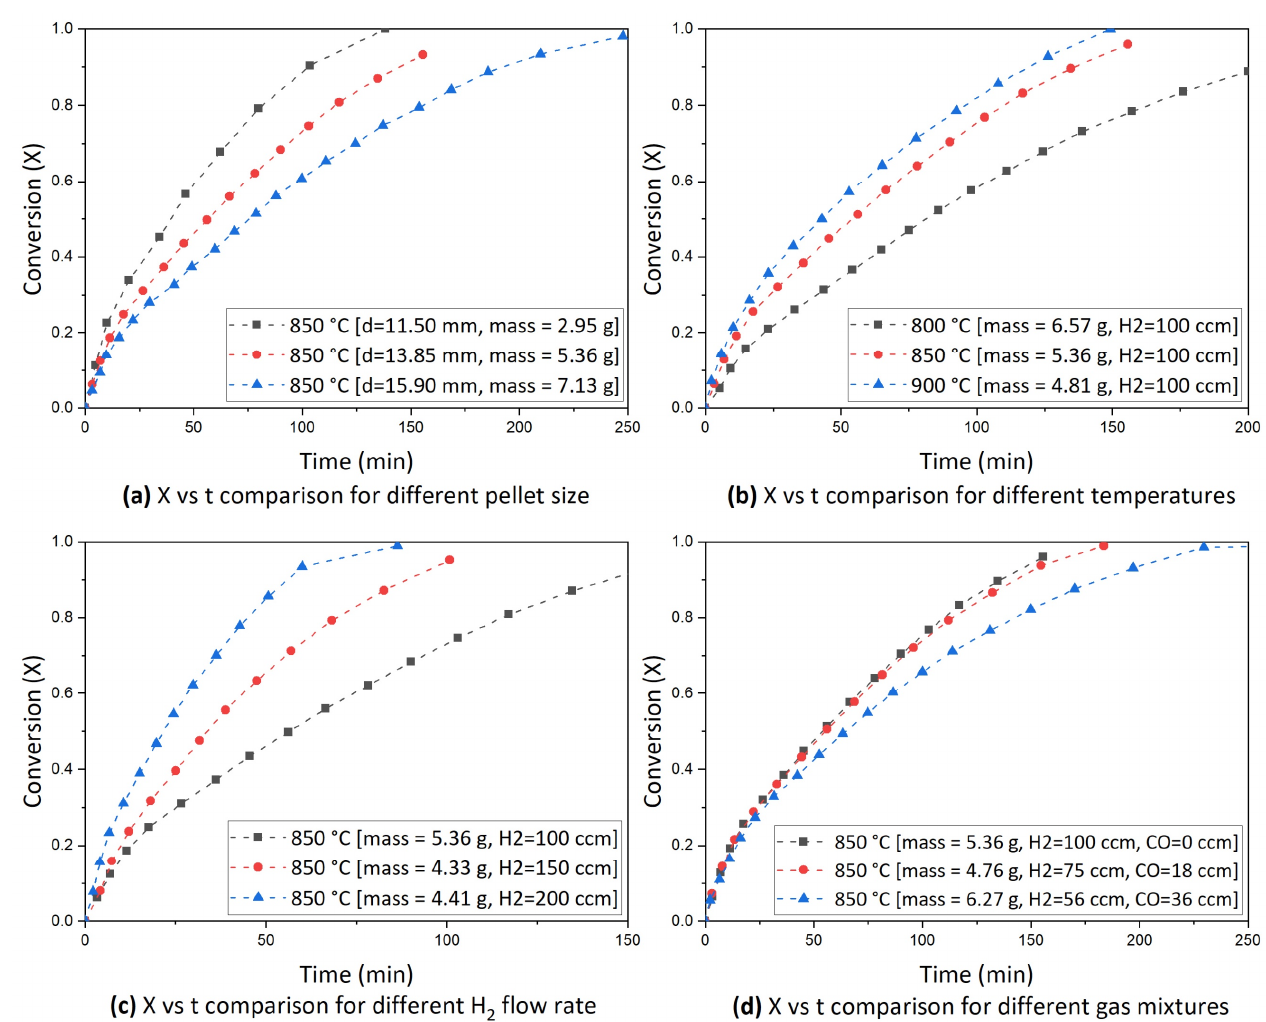
Figure 3. Comparison of X vs. t curves for experiments performed with ( a ) different pellet size; ( b ) different reduction temperatures; ( c ) different H 2 flow rates; and ( d ) for different gas mixtures.